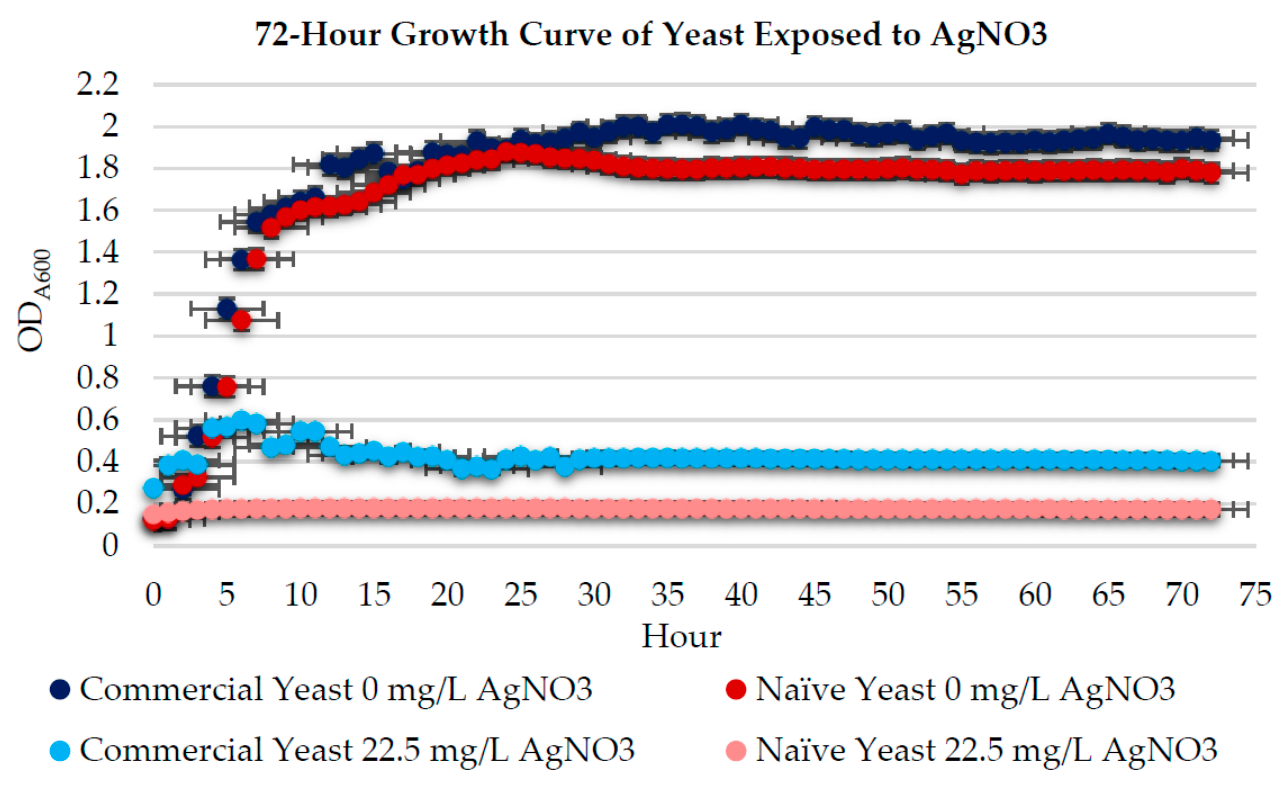
Figure 3. Growth curves for NS commercial ( n = 24) and naïve ( n = 24) yeast exposed to 0 mg/L AgNO 3 and the sub-MIC (22.5 mg/L AgNO 3 ). Error bars represent percentage error (5%).